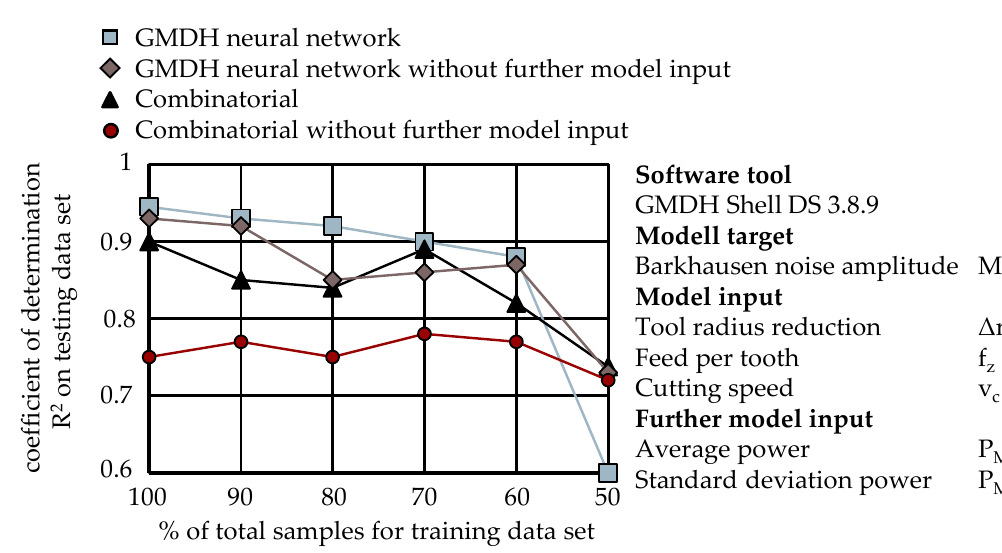
Figure 5. Performance of different machine learning algorithms for different training data set